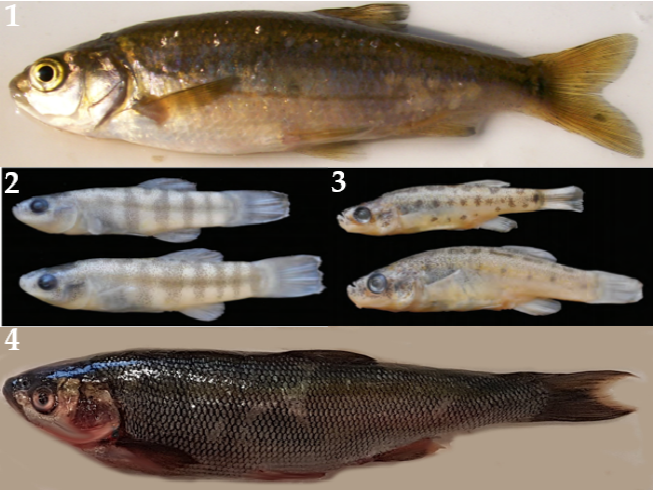
Figure 2. Pictures of some representative species endemic to Turkey: 1: Pseudophoxinus alii ; 2: Aphanius transgrediens ; 3: A. sureyanus ; 4: Alburnus tarichi . (Original photos by Deniz Innal.) Considering the 62 endemic species listed in Table 2 according to their IUCN categories, an alarming result emerged (Figure 3).